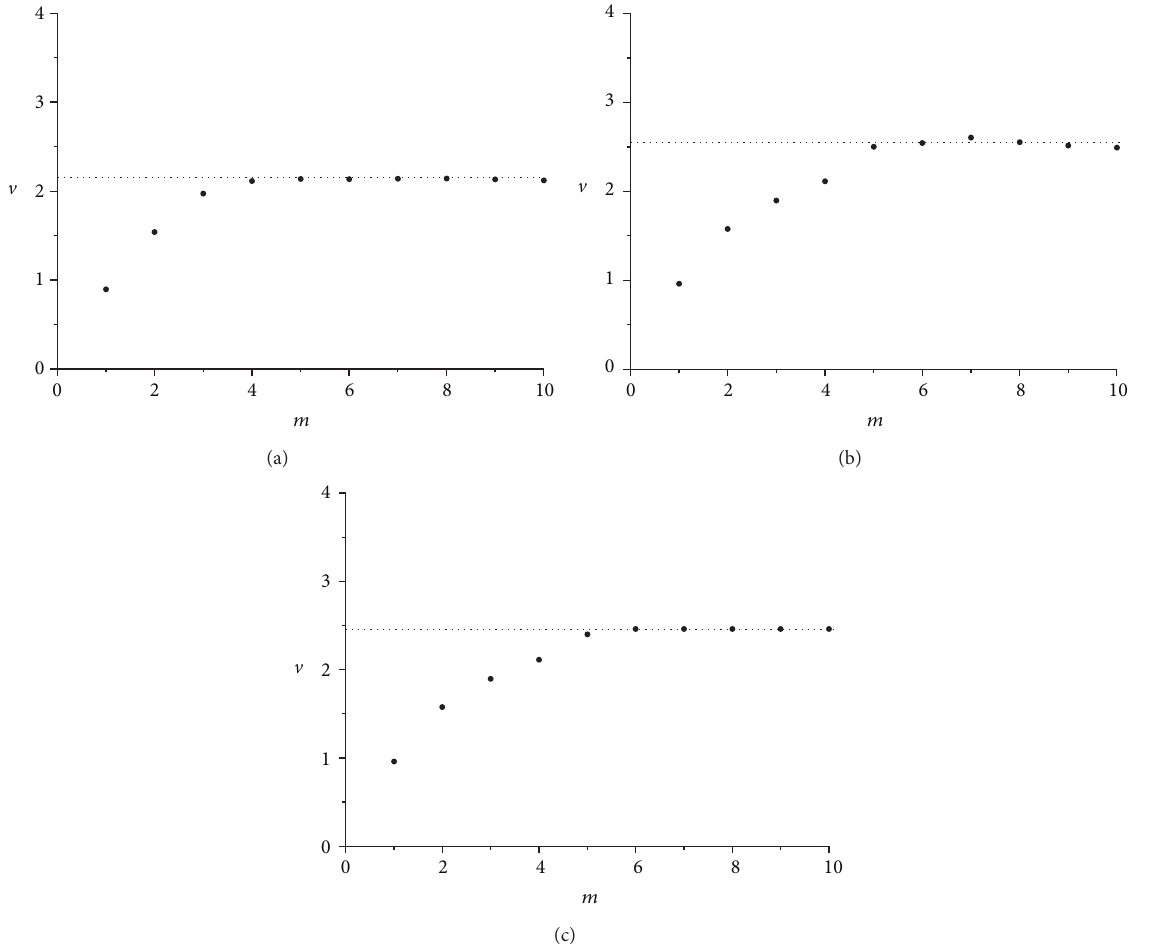
Figure 8: Correlation dimension V versus 𝑚 embedding dimension for roll angle 𝛼(𝑡) time-series in the cases of (a) wax, V = 2.13 , (b) gypsum, V = 2.54 , and (c) lead solder, V = 2.06 . In all cases, minimum embedding dimension under these conditions is 3.